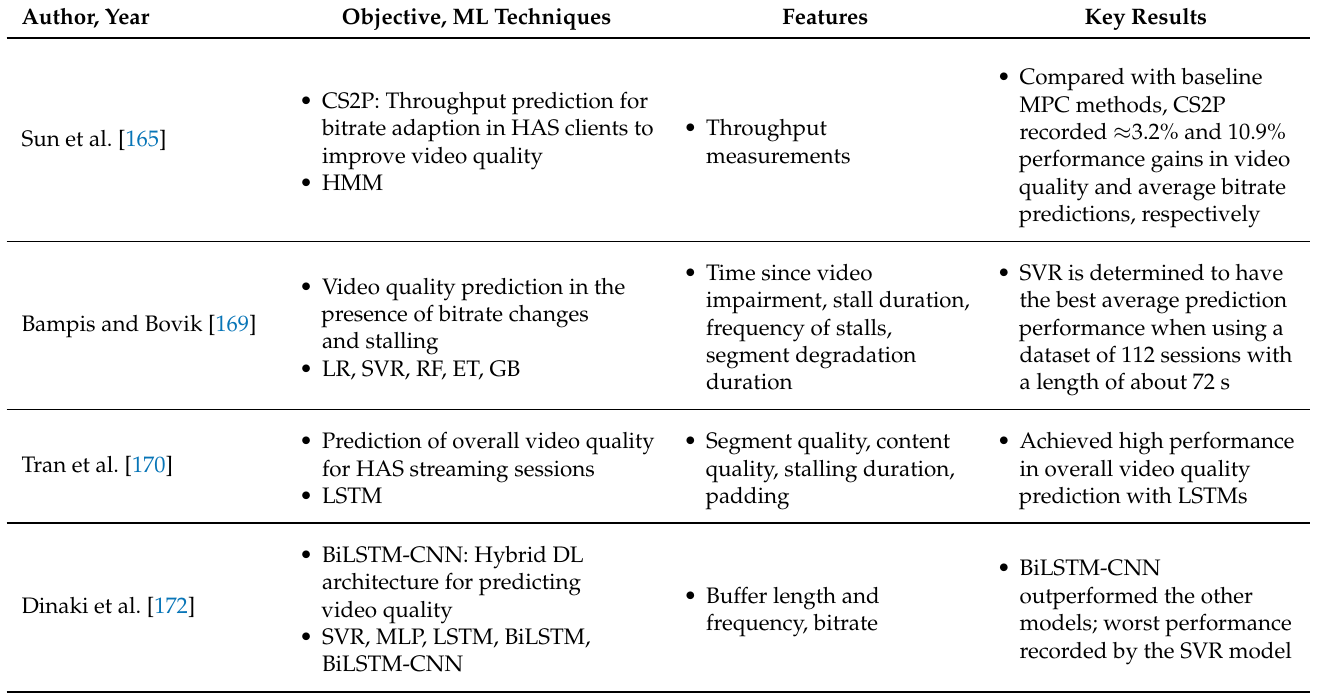
Table 4. Summary of QoD prediction for HAS and